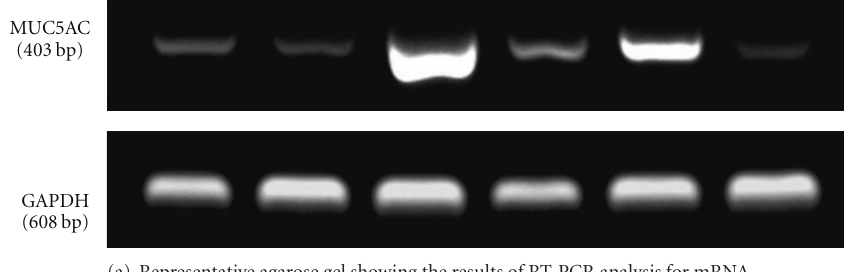
(a) Representative agarose gel showing the results of RT-PCR analysis for mRNA